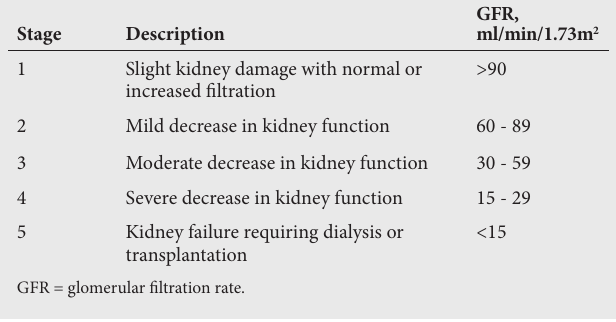
Table 1. Measurement of kidney functioning and staging